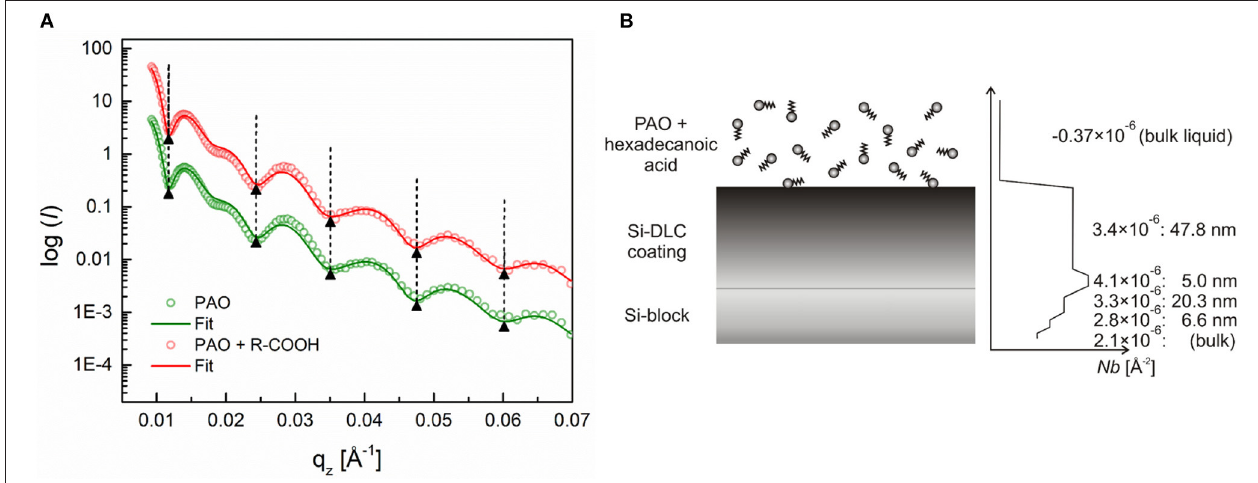
FIGURE 6 | (A) Neutron reflectivity profiles (dots) and best fits (continuous lines) for an a-C:H:Si coating measured in pure PAO oil and a 0.7 wt.% solution of hexadecanoic acid, (B) Schematic of the additive adsorption on an a-C:H:Si DLC coating and the SLD profile extracted from the fitted curve. Adapted from Simi ˇ c et al. (2014).